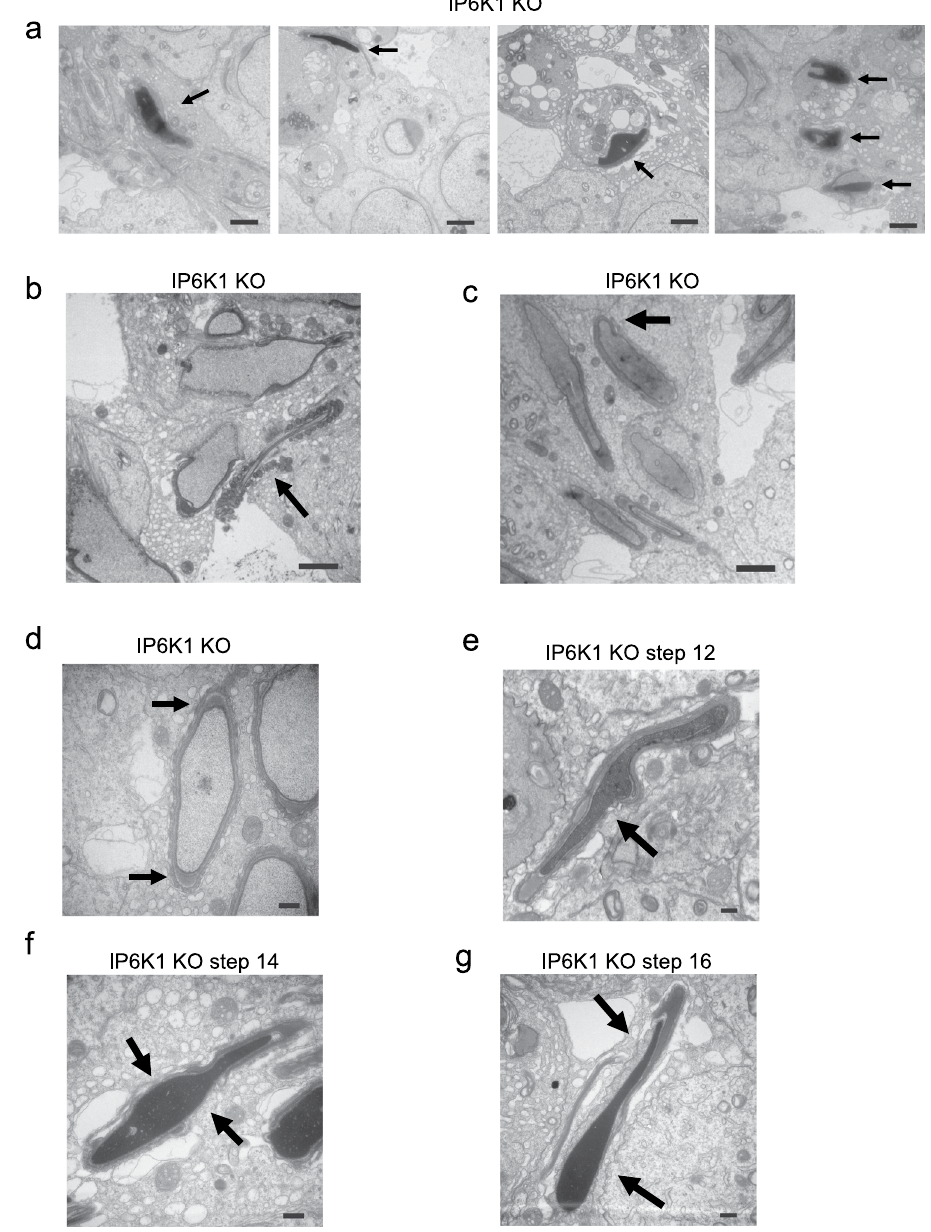
Figure 6. IP6K1 deletion disrupted spermatid cell polarity and caused degeneration of acrosomes. ( a – g ) Evaluation of spermatids by electron microscopy. ( a ) Sperm cells were engulfed (arrows) by Sertoli cells in stage VII and stage VIII seminiferous tubules of IP6K1 KOs. Scale bar 2 μ m. ( b ) Severed sperm tails (arrow) showed in stage IX seminiferous tubules. Scale bar 2 μ m. ( c ) Disorientation of elongating spermatids (arrow) in IP6K1 KOs. Scale bar 2 μ m. ( d ) Spermatids lost cell polarity in IP6K1 KOs. Picture shows spermatid with double acrosome granules (arrow). Scale bar 2 μ m. ( e ) Disconnected acrosome (arrow) was evident in step 12 spermatids of IP6K1 KOs. Scale bar 500 nm. ( f ) The integrity of acrosomes was disrupted (arrows) in step 14 spermatids of IP6K1 KOs. Scale bar 500 nm. ( g ) The step 16 spermatids from IP6K1 KOs lost a major part of acrosomes (arrows). Scale bar 500